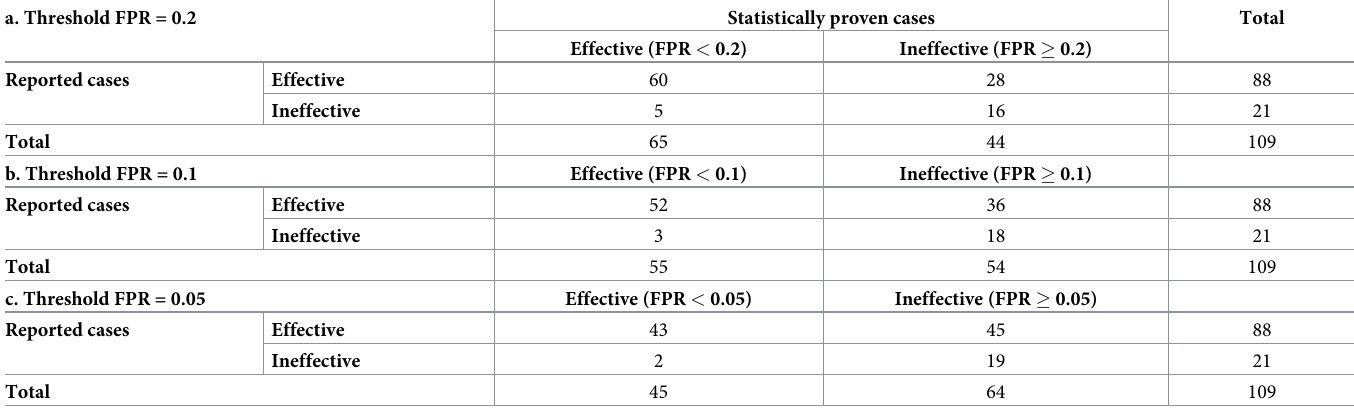
Table 1. Distribution of the numbers of reported and statistically proven effective and ineffective cases of electric fence applications under the thresholds of (a) FPR = 0.2, (b) FPR = 0.1 and (c) FPR = 0.05. a. Threshold FPR =